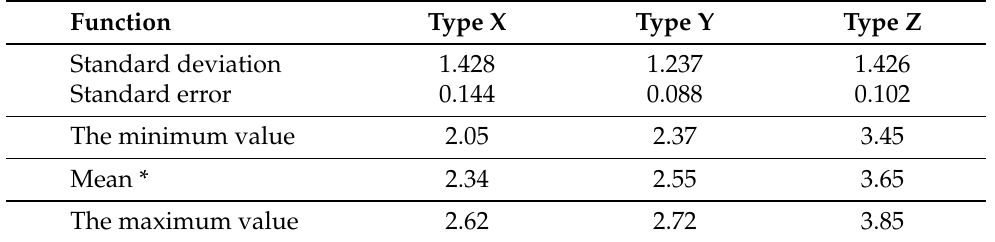
Table 5. Descriptive statistics for the dependent variable “Degree of Aesthetic Preference” for